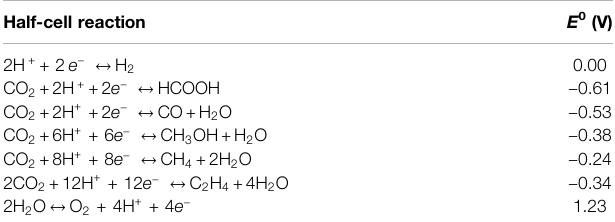
TABLE 1 | Half-cell reactions and the corresponding formal redox potential E 0 (V) for the electrochemical reduction of CO 2 . All potentials are referenced against the standard hydrogen electrode (Bard et al.,